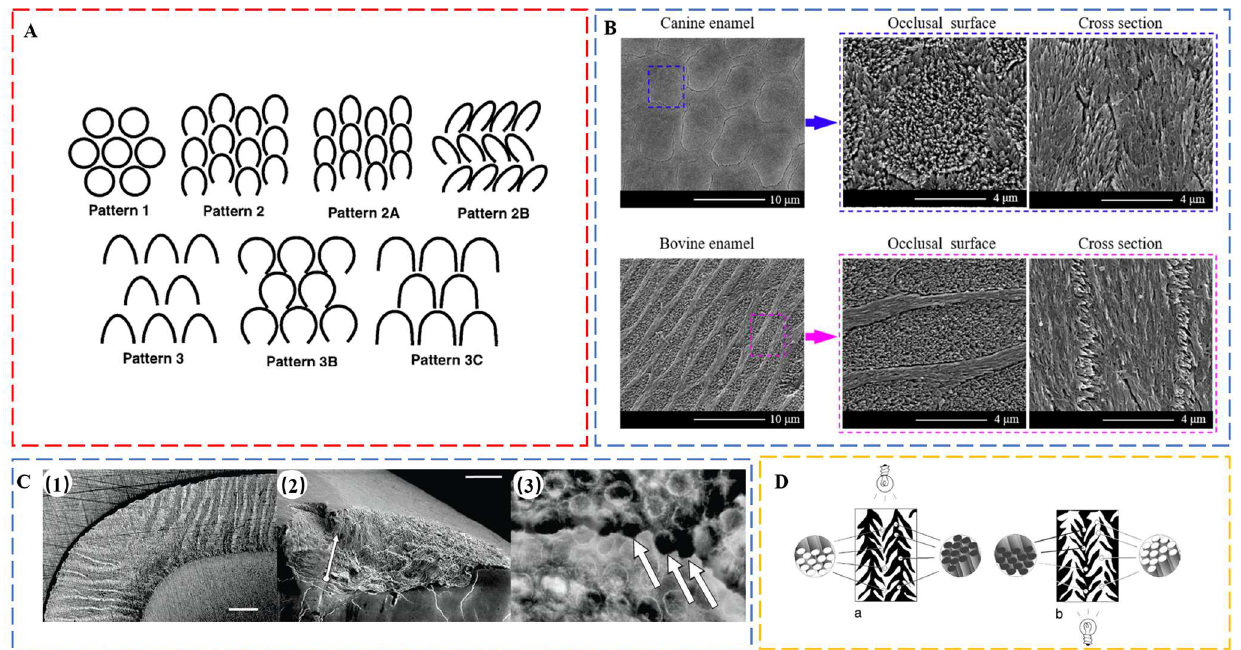
Figure 2. ( A ) Diagram of Boyde’s prism patterns. Pattern 1 prisms are usually small (3 to 5 μm) and have complete, roughly circular boundaries. Prisms are completely separated by interprismatic enamel and are arrayed in offset horizontal rows. Close to the outer enamel surface, the prisms of most mammals resemble Pattern 1. Boyde’s Pattern 2 and Pattern 3 defined two major classes of prisms with incomplete prism boundaries and arc-shaped prism sheaths. In both of these prism patterns, the open side of the prism is toward the cervix (root–crown junction) of the tooth. Pattern 2 prisms are small at 2 to 4 μm in diameter and are arranged in longitudinal columns from the apex to the cervix. Pattern 2 variants (Patterns 2, 2A, and 2B) differ in the amount and distribution of interprismatic enamel and angles between prisms in adjacent rows. Pattern 3 prisms are larger at 5 to 8 μm in diameter and packed in horizontally offset rows, which is similar to Pattern 1 prisms. The variants (Patterns 3, 3B, and 3C) differ in the shape of the prism sheath and the amount and distribution of interprismatic enamel. Although Boyde’s scheme has been widely used in primate enamel studies, prism patterns in many primate species are so variable that it may be more practical to distinguish only between ‘‘closed’’ (Pattern 1) and ‘‘open’’ (Patterns 2 and 3) prisms. Reproduced with permission from M.C. Maas et al. [51], Wiley. ( B ) SEM micrographs of the occlusal surfaces and axial sections of canine and bovine enamel. Reproduced with permission from H. Xiao et al. [65], Elsevier. ( C ) Sea otter enamel. (1) Light microscopy (LM) image shows high degree of decussation in sea otter enamel. HSB extend to the tooth surface. Scale bar, 0.2 mm. (2) Enamel chip; arrow indicates measurement of h. Scale bar, 0.5 mm. (3) LM at higher magnification showing the circular outlines of prisms in cross-section (each approx. 4 mm in diameter). Arrows indicate where cracks have entered prism edges. Reproduced with permission from C. Ziscovici et al. [68], the Royal Society. ( D ) Interpretation of prism direction in secondary vertical prism decussation of Crocuta, based on position of illumination and differential absorption/reflection of light by prisms. Reproduced with permission from J.M. Rensberger et al. [71], Springer